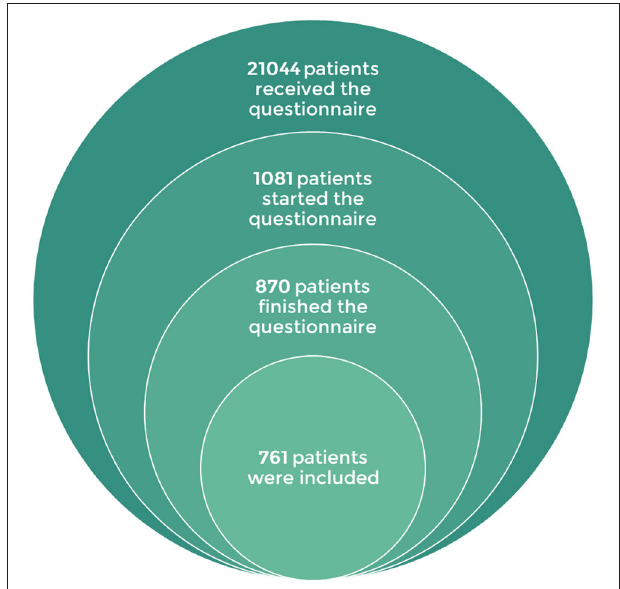
FIGURE 3 | Stacked Venn diagram showing patients’ inclusion.